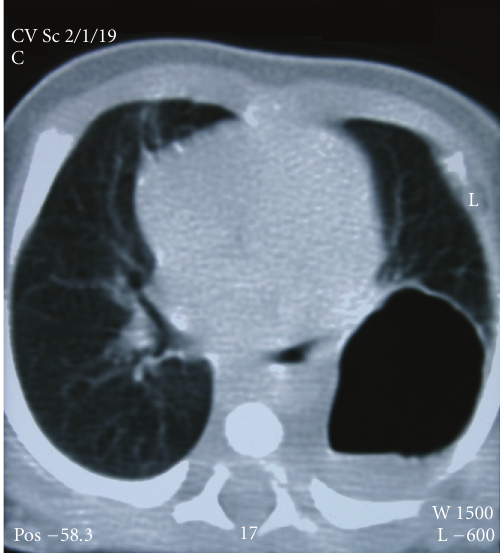
Figure 3: CT imaging of the ballooning of the cyst after birth.